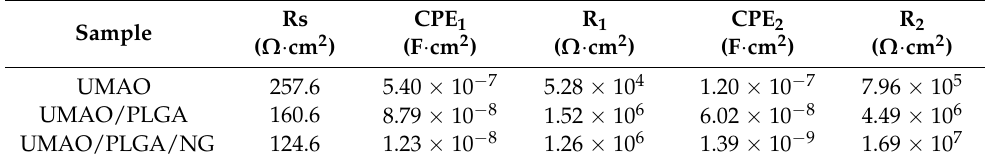
Table 4. Values of the equivalent circuit parameters for the different